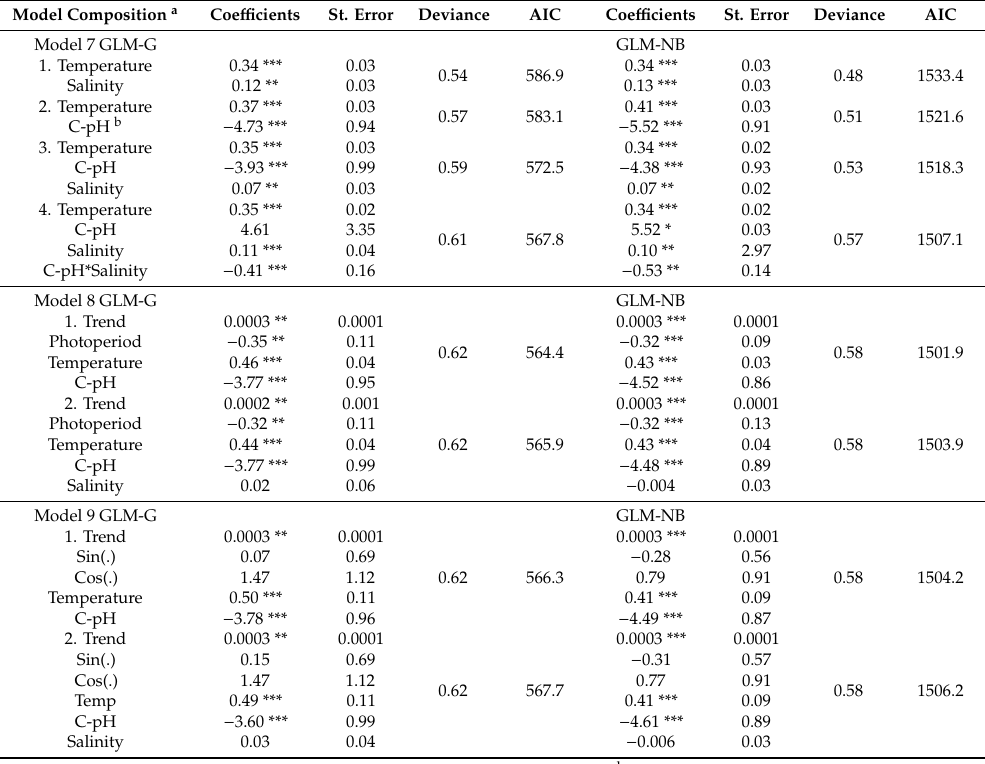
Table 4. The sequential building of multiple regression models for V. parahaemolyticus concentrations in oysters using Gaussian (GLM-G) and negative binomial (GLM-NB) models (Models 7, 8, 9). Model Composition